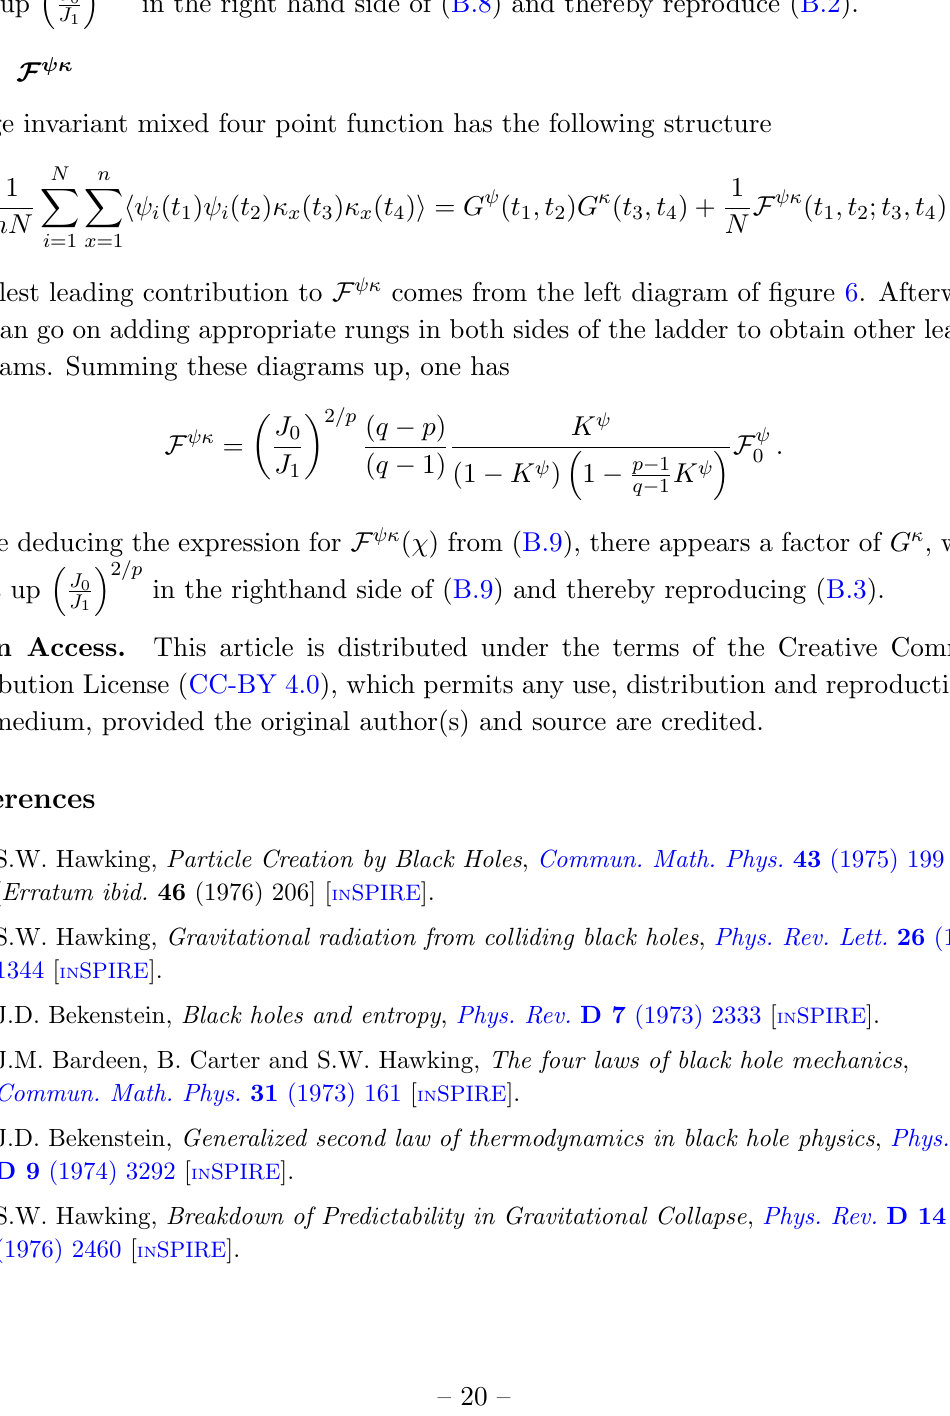
Figure 6 . Simplest \melonic" contribution to mixed four point function in large N limit. While deducing the expression for F (cid:20) ( (cid:31) ) from (B.8), there are two factors of G (cid:20) which (cid:16) (cid:17) 4 =p J 0 soak up in the right hand side of (B.8) and thereby reproduce J 1